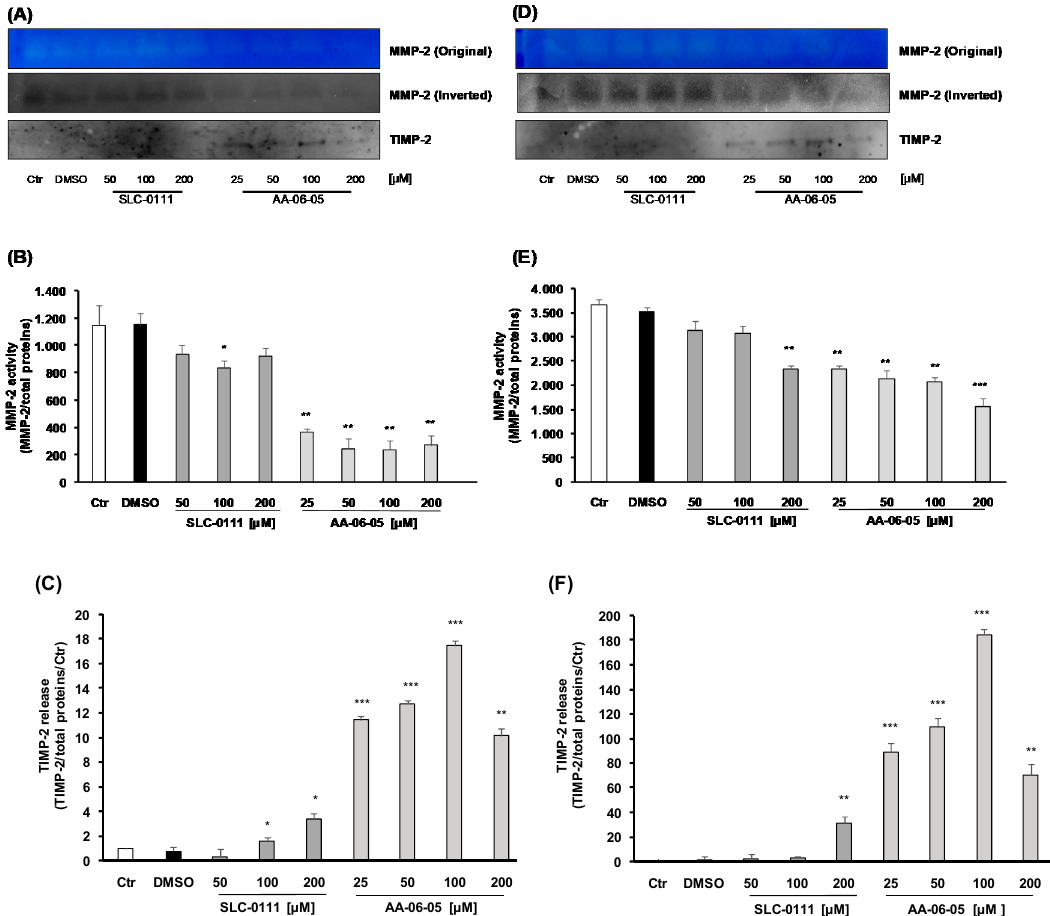
Figure 8. Zymographic analysis of conditioned medium from cultured MDA-MB-231 and A549 cells treated with CA-IX pharmacological inhibitors. Tumor cells were treated with increasing concentrations of SLC-0111 [50–200 µM] and AA-06-05[25–200 µM], in serum-free medium. Conditioned medium was collected, in triplicate, after 48h and analyzed by gelatin zymography. MMP-2 activity in conditioned media of MDA-MB-231 ( A , B ) and A549 ( D , E ) was assessed as lysis bands on blue background and quantified in the inverted images as optical density (± SD)/total proteins in the sample. ( n = 3). * p < 0.05, ** p < 0.01 and *** p < 0.001 vs untreated cells (Ctr). Western blot analysis was performed in parallel experiments to evaluate the release of TIMP-2 in the conditioned medium of MDA-MB-231 ( C ) and A549 ( F ). For each experimental condition TIMP-2 release was reported as optical density (± SD) / total proteins in the sample vs. basal control. ( n = 3). * p < 0.05, ** p < 0.01 and *** p < 0.001 vs untreated cells (Ctr).